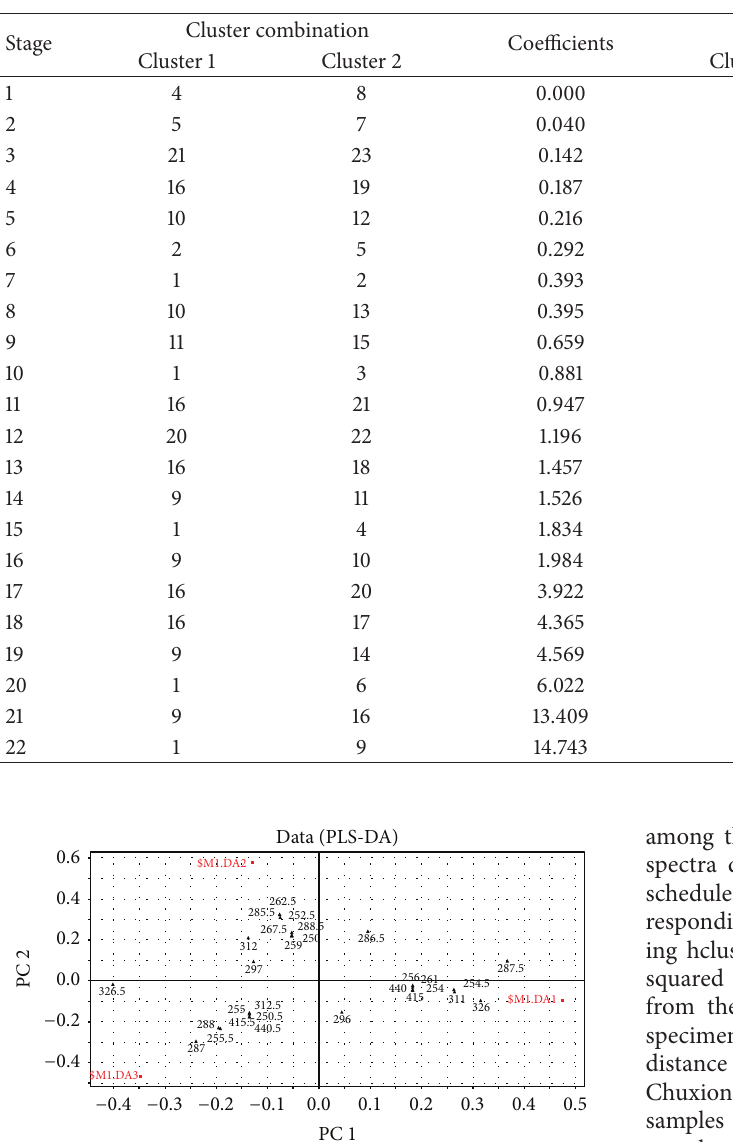
Table 3: Agglomeration schedule of HCA.